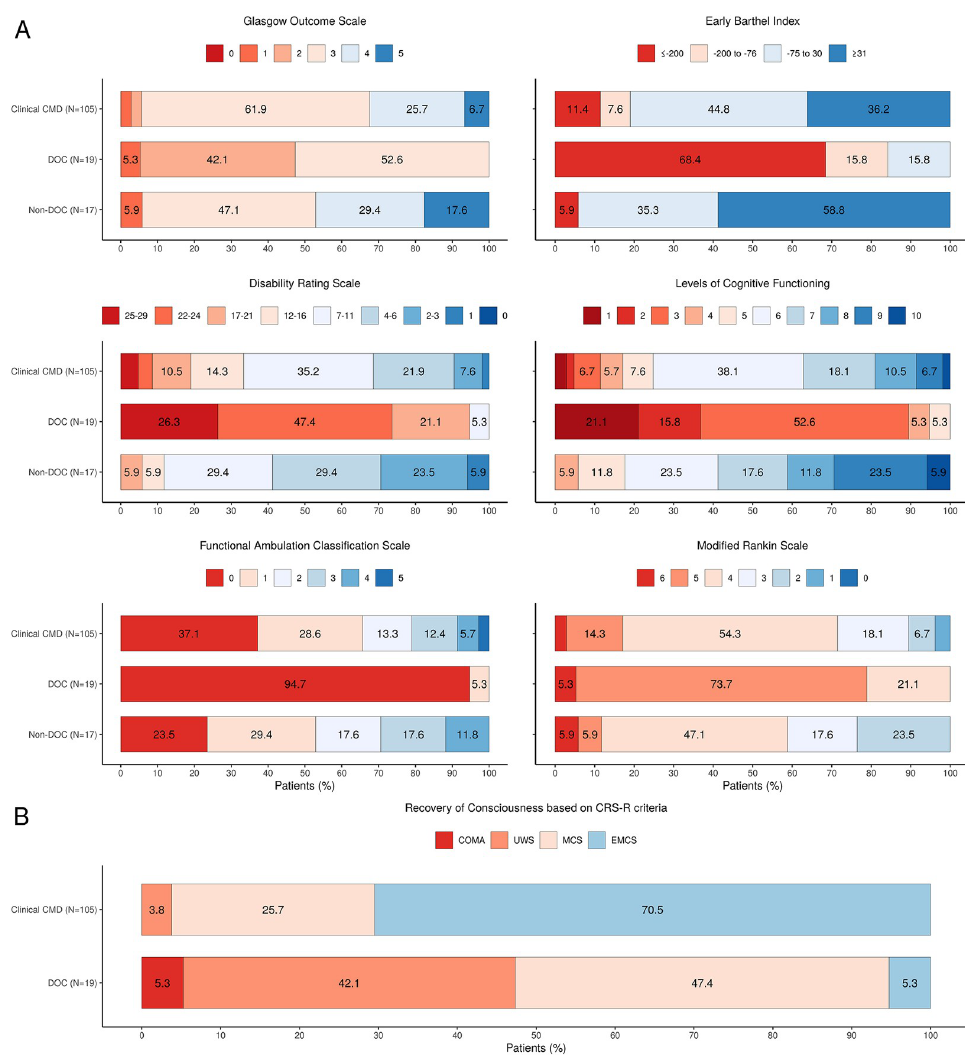
Fig 1. Scores and categories on the outcome measurements and recovery of consciousness according to Coma Recovery Scale-Revised criteria at discharge. Patients are categorized into three groups according to initial neurobehavioral diagnosis at admission using the Coma Recovery Scale-Revised and the Motor Behavior Tool: clinical Cognitive Motor Dissociation (CMD); Disorders of Consciousness (DOC); Non-DOC. (A) Score on the Glasgow Outcome Scale (GOS) range from 1 to 5, with 5 indicating good recovery; Category on the Early Barthel Index (ERBI) range from -325 to 100, with 100 indicating complete functional independence; Category on the Disability Rating Scale (DRS) range from 0 to 29, with 0 indicating absence of disability; Category on the Rancho Los Amigos Levels of Cognitive Functioning (LCF) range from 1 to 10, with 10 indicating modified independent; Category on the Functional Ambulation Classification Scale (FAC) range from 0 to 5, with 5 indicating ambulator-independent; Score on the modified Rankin Scale (mRS) range from 0 to 6, with 0 indicating no symptoms. Good outcomes were considered as GOS > = 4, ERBI � -75, DRS < = 11, LCF � 6, FAC � 2 and mRS � 3. The red range corresponds to score/category considered as poor. The blue range corresponds to score/category considered as good. (B) Recovery of Consciousness according to CRS-R criteria per CMD and DOC groups. UWS = unresponsive wakefulness syndrome; MCS = minimally conscious state; EMCS = emergence from minimally conscious state.